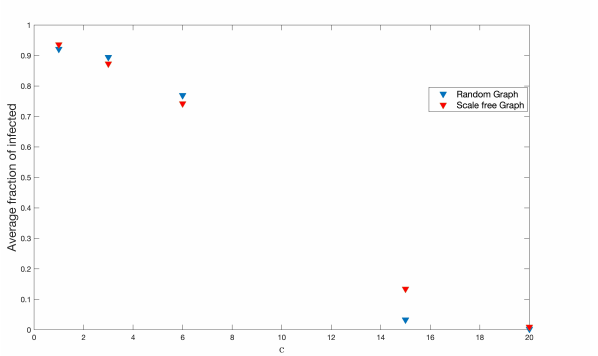
Figure 16. Infected average for the different values of c in random and scale-free graph.